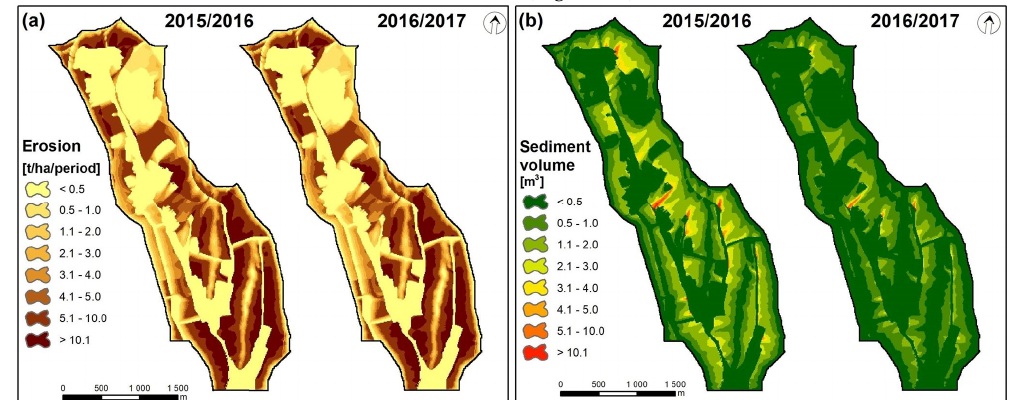
Figure 7. Results from the EROSION-3D model (calculated for a function A): ( a ) Erosion intensity; ( b ) Volume of sediment.